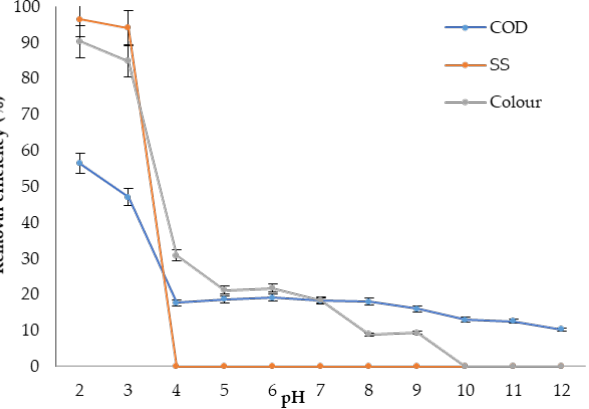
Table 3. Comparison of previous and current studies for best pH values of various natural coagu- lant.